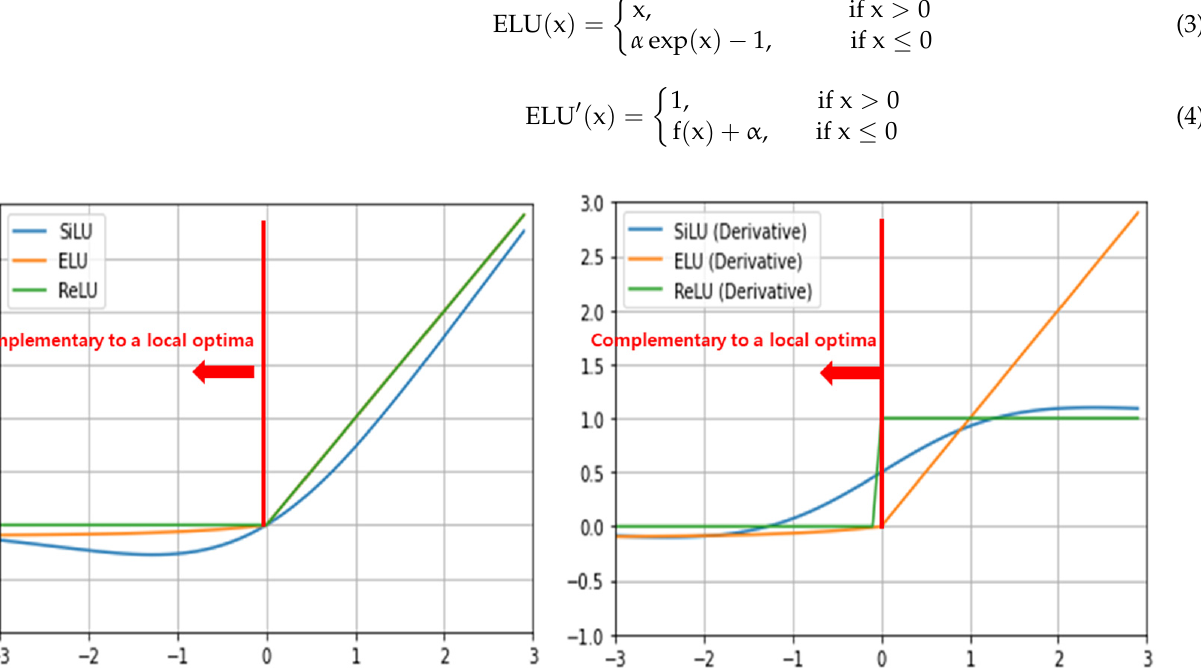
Figure 2. Graph comparison of SiLU, ELU, and ReLU activation function ( Left figure is function, Right figure is a derivative function).